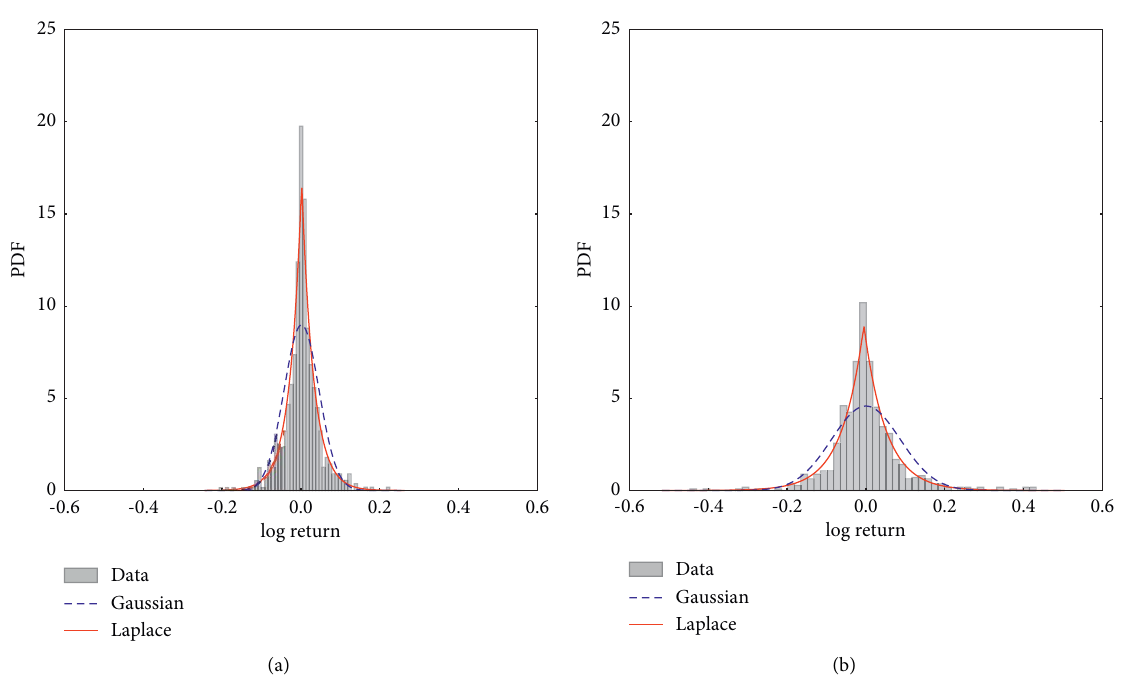
Figure 1: Probability density function of log returns in the new and old forks. Following the Freedman–Diaconis rule [39], we plotted the